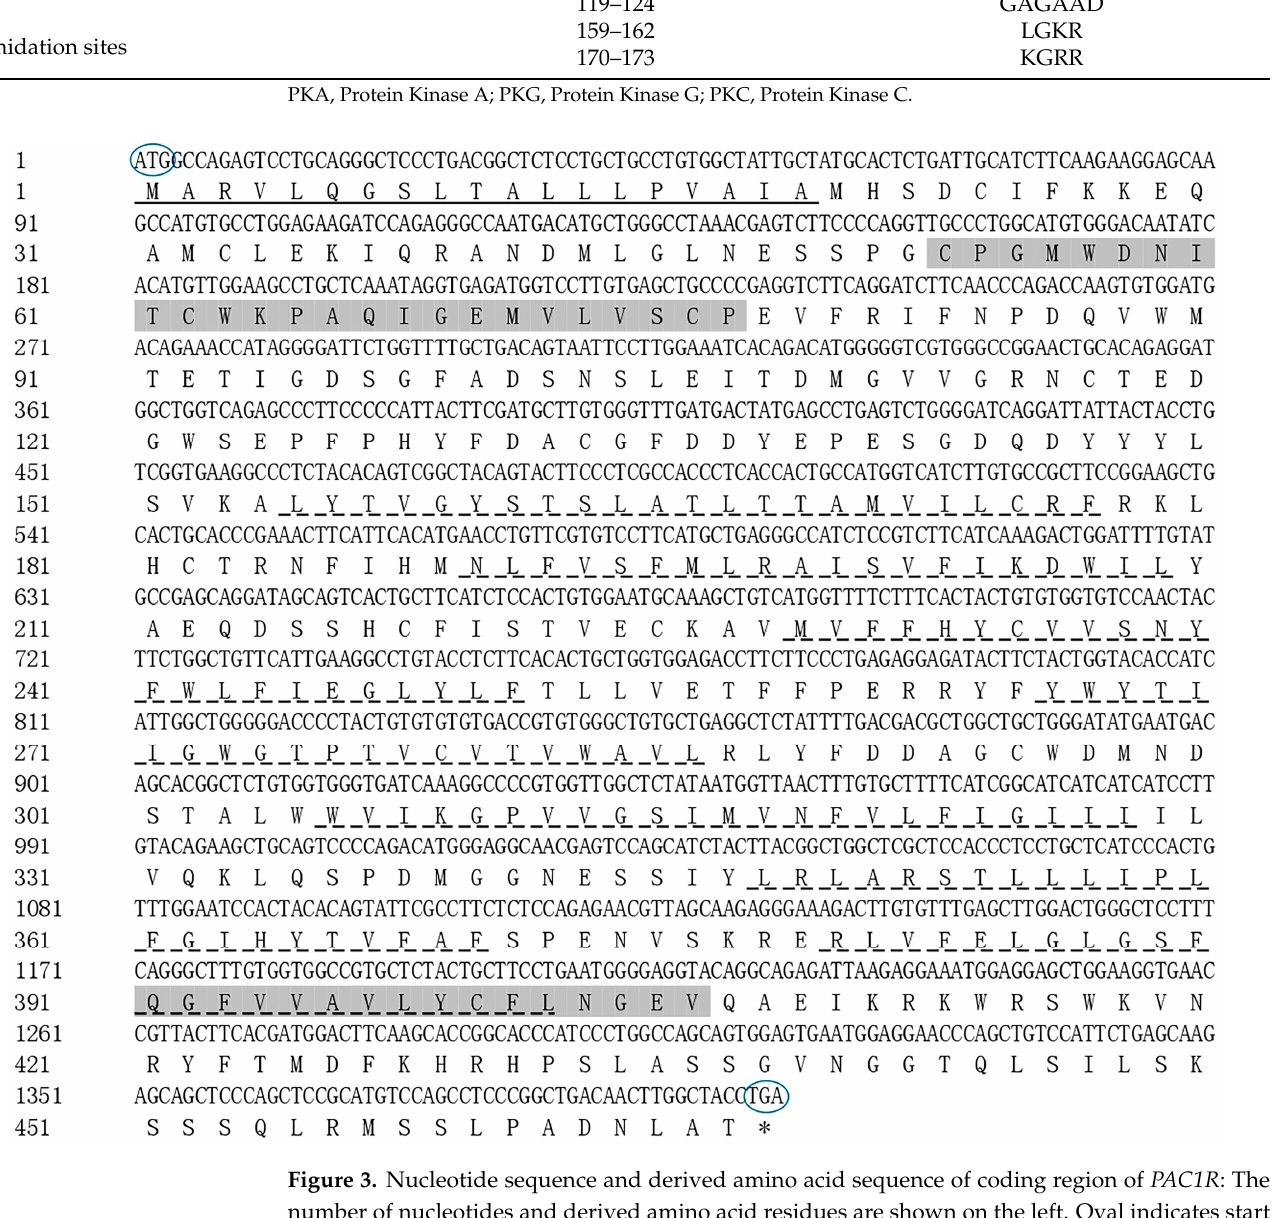
Table 1. Post-translational modification site of PACAP.